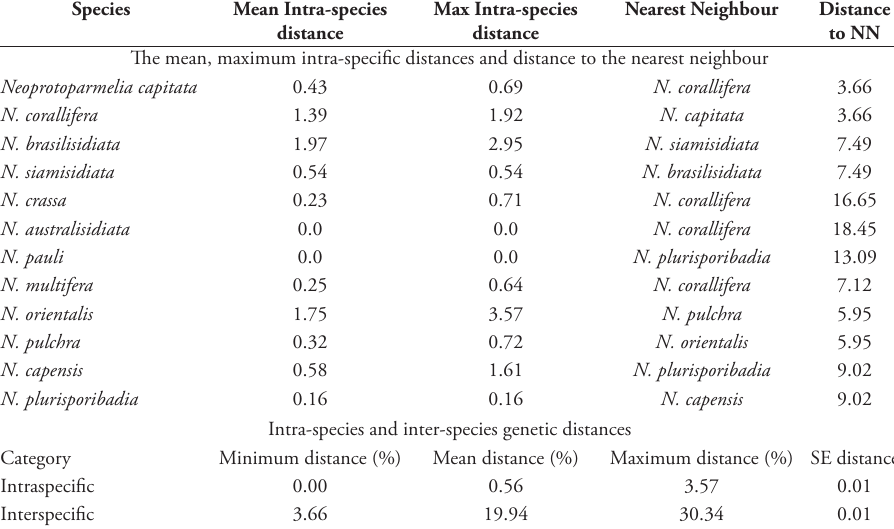
Table 2. Genetic distances amongst Neoprotoparmelia species. Species Mean Intra-species Max Intra-species Nearest Neighbour Distance distance distance to